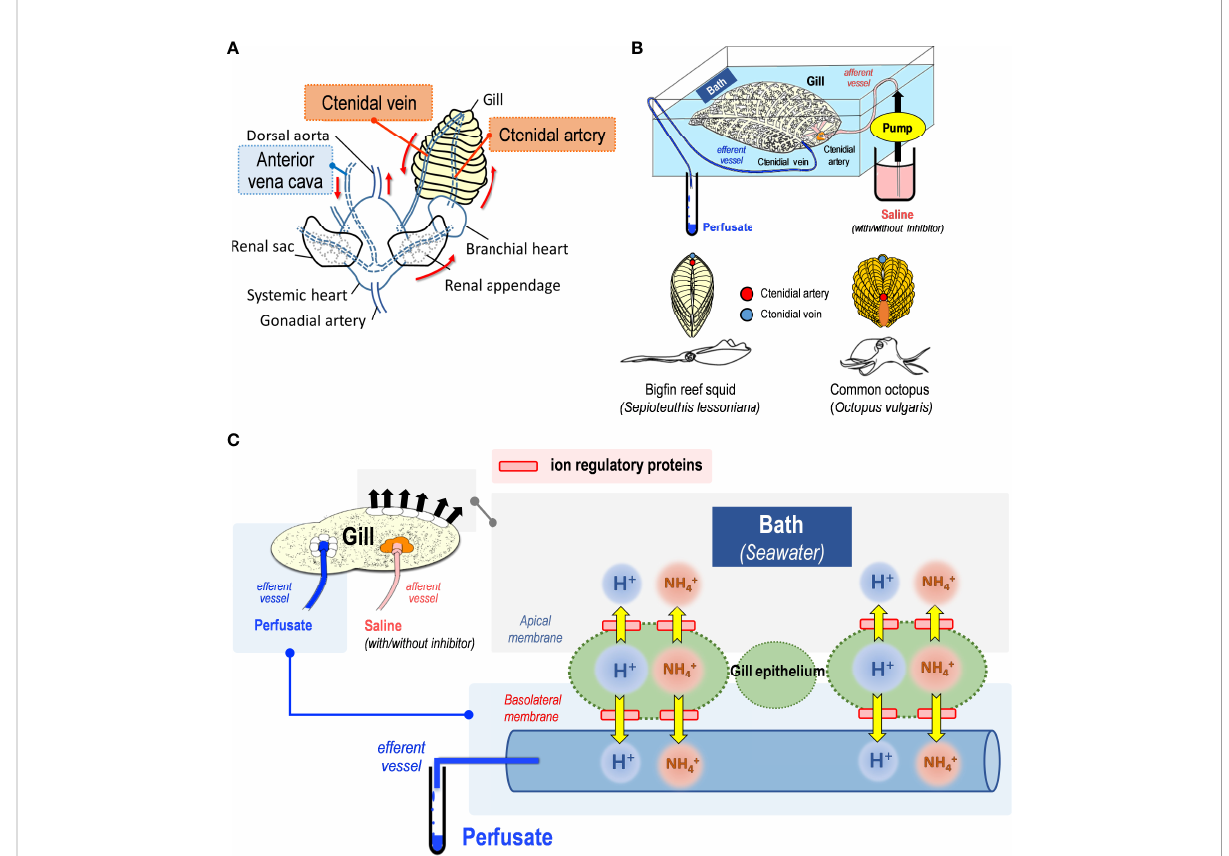
FIGURE 1 Representative images of blood circulation in cephalopod gills and ex-vivo approach. (A) The closed circulation system of cephalopods. The arrows indicate the direction of blood fl ow in the vessels. Vessels (anterior vena cava, ctenidial artery and ctenidial vein) where blood samples were taken were highlighted in background colors. (B) The schematic model of the ex-vivo perfusion experiment in the gills. During the experiments, the gills were incubated in a fi ltering seawater bath. The perfusate was collected from the efferent side of the tubing. (C) The sample collected from perfusate represents the fl uid transport from the basolateral side of the gill epithelium to the circulating blood via the ctenidial